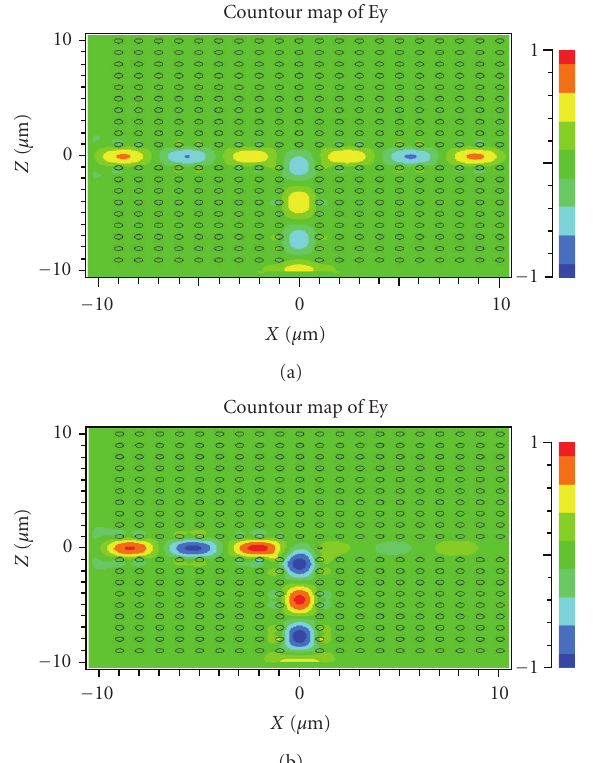
Figure 1: Simulations for photonic crystal T-junction. (a) Beam splitting obtained without placing the nanoparticle. (b) Addition of 100nm particle in the T-junction diverts the light towards the left output channel.